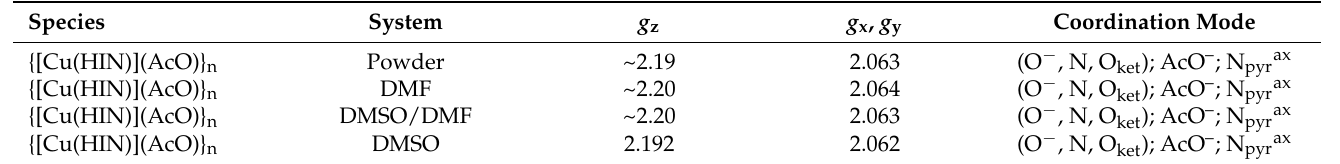
Figure 3. X-band anisotropic EPR spectra recorded at 120 K on the polycrystalline complex {[Cu(HIN)](AcO)} n : ( a ) solid powder; ( b ) dissolved in DMF and ( c ) dissolved in DMSO. With the arrows the position of g z and g x , g y is indicated. Table 2. Spin Hamiltonian parameters of copper(II) complex formed by HIN.